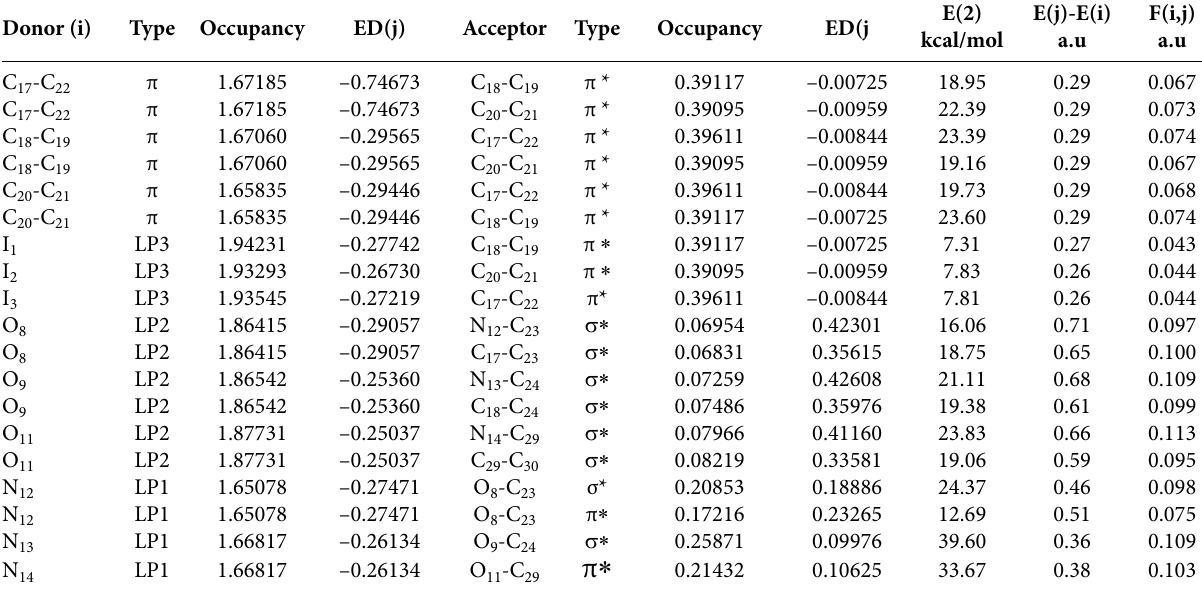
Table 7. Selected second-order perturbation energy (E (2) kcal/mol) with values greater than 10 kcal/mol (except for iodine interaction) for Iopami- dol in gas phase. Donor